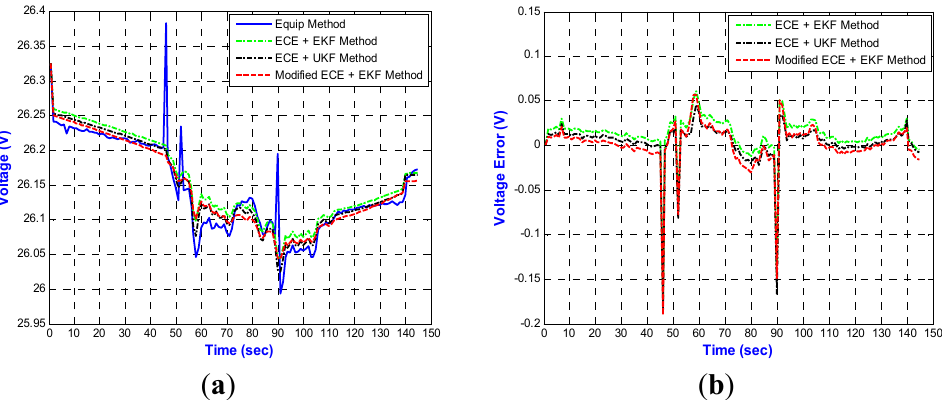
Figure 21. Modeling results in the humanoid robot test ( a ) Voltage profile; ( b ) Voltage error profile.